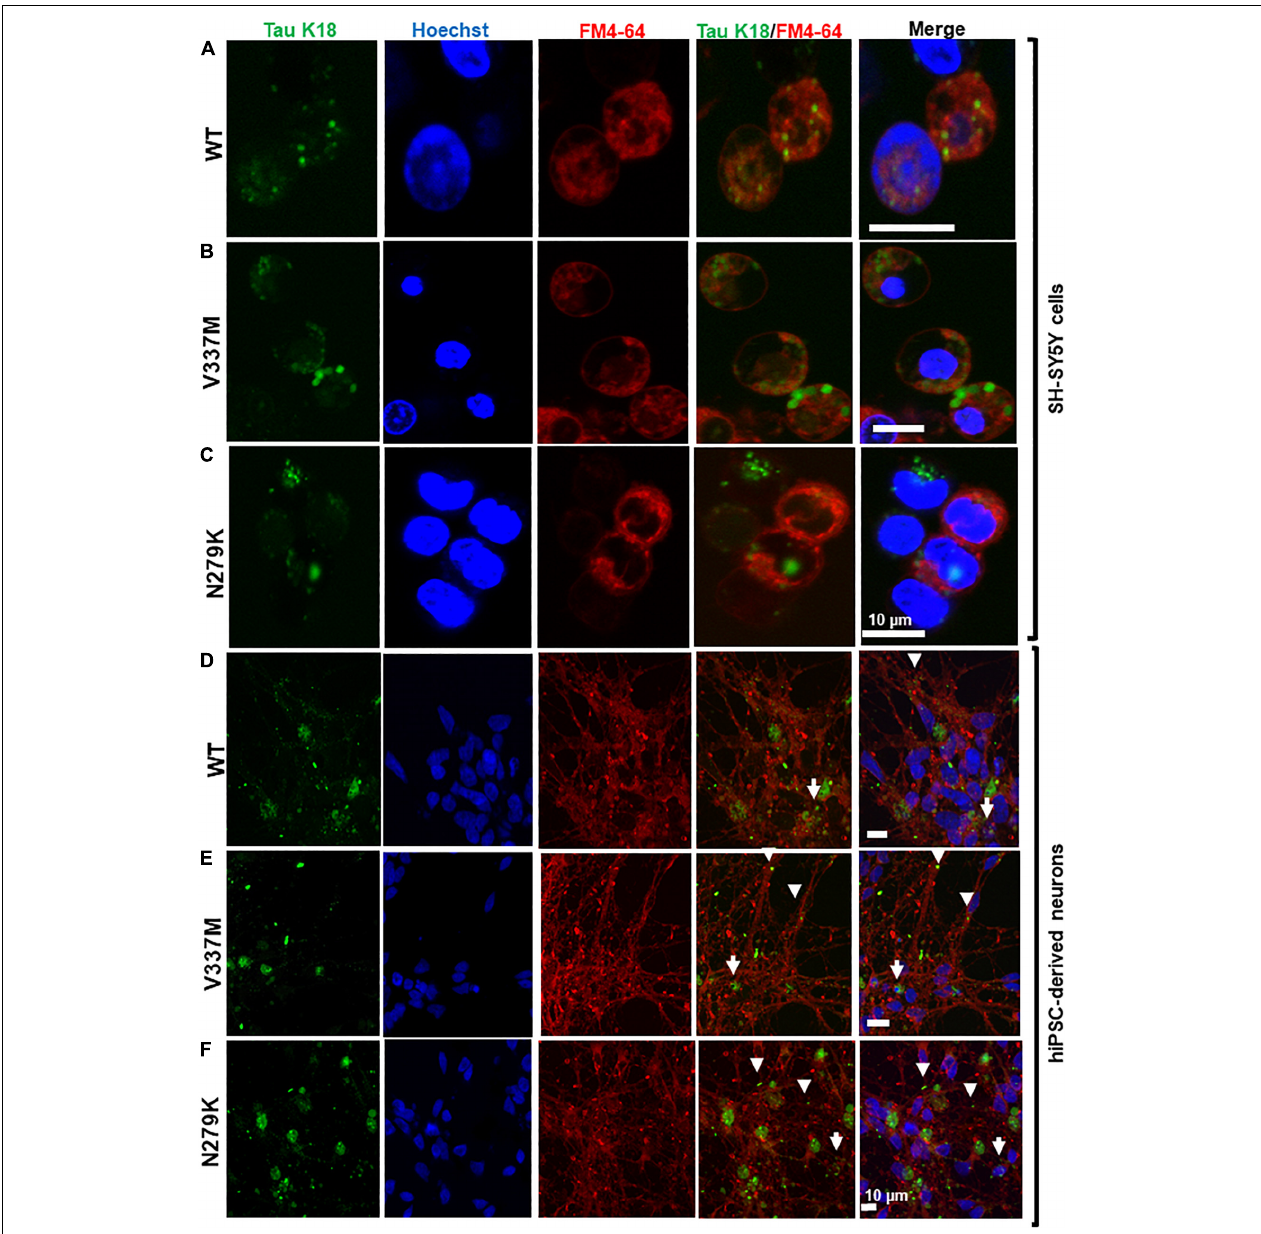
FIGURE 6 | Extracellular tau K18 oligomers are taken up by endocytosis, with the internalized soluble aggregates localizing to the neurites and soma of hiPSC-derived neurons. Panels (A–C) , respectively, show co-localization of oligomers of K18-WT, K18-V337M, and K18-N279K internalized by SH-SY5Y cells with the FM4-64 endocytosis marker. (D–F) Internalized exogenous oligomers of K18-WT, K18-V337M, and K18-N279K, respectively, co-localized with the FM4-64 endocytosis marker in hiPSC-derived neurons. Whilst some of the internalized oligomers of all three protein variants were found in the neurites (arrowheads), others appeared to be present in the soma (arrows). Scale bar = 10 µ m for all